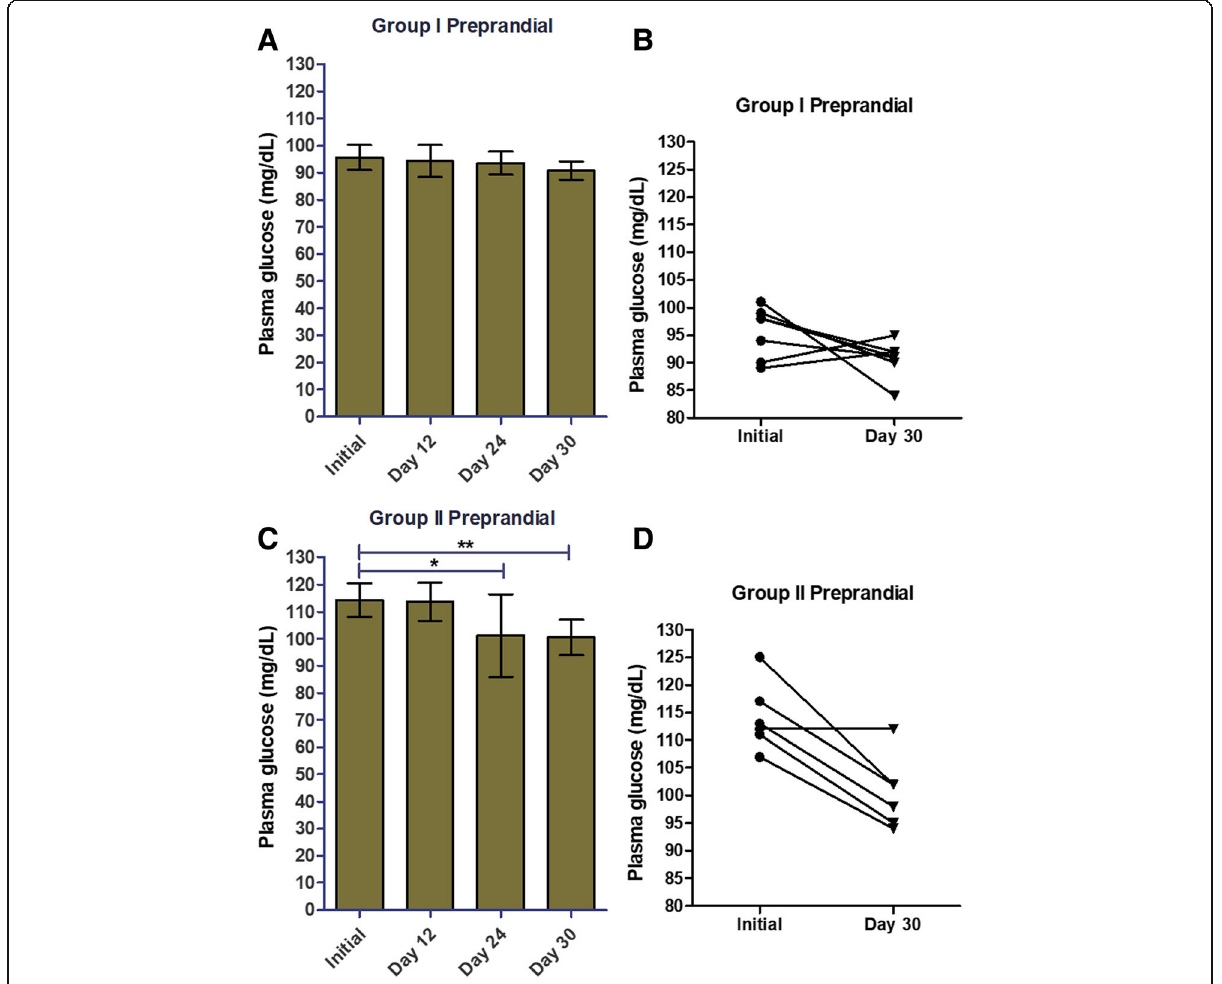
Fig. 2 PCE supplementation reduces preprandial glucose levels in the prediabetes group, but not in the group with blood glucose already within normal range. On the initial day of the study , we divided individuals into two groups based on their preprandial (before lunch) plasma glucose levels: a - b , Group I, ≤ 100 mg/dL; c - d , Group II, 101 – 125 mg/dL. Pre-prandial plasma glucose levels were measured and recorded on days 1 (initial), 12, 24, and 30 ( a , c ). We plotted individual study subject plasma glucose levels for the initial day and day 30 of the study ( b , d ). Data shown are mean ± SD for a and c . We calculated statistical significance (*, p ≤ 0.05; **, p ≤ 0.01) by comparing glucose levels measured at each time point to the initial value using a two-tailed t-test in GraphPad Prism 5.0